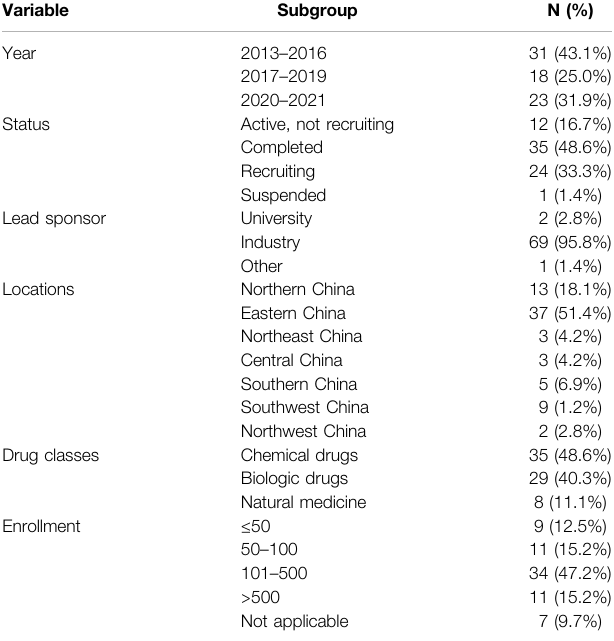
TABLE 1 | Characteristics of all included trials.